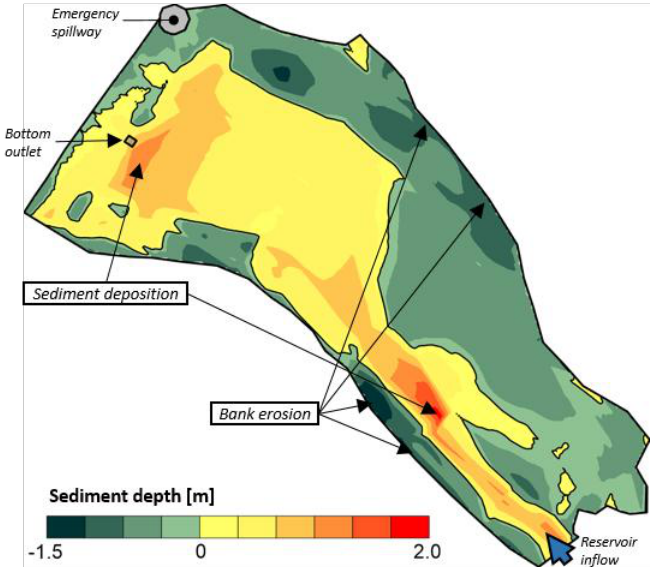
Figure 7. Map of the depth of the sediment of the Vrbovce SWR calculated by subtracting digital elevation models (DEMs) from the 2017 and 2008 surveys.